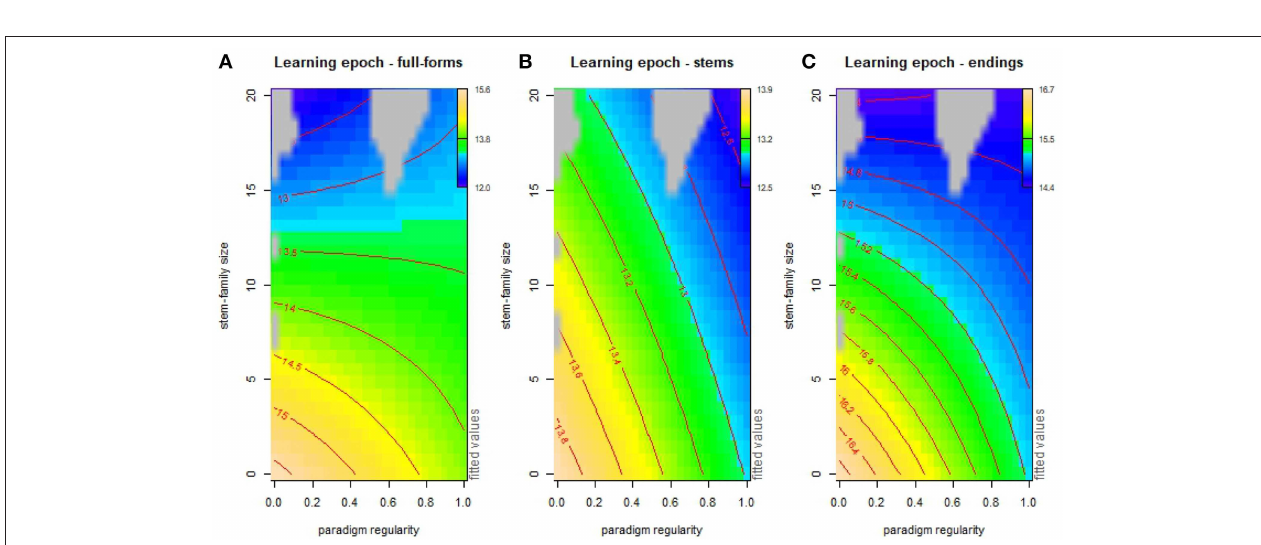
FIGURE 11 | (A) Regression plot of time of lexical acquisition by size of stem-family in linear interaction with word length. Fixed effects are word length (as categorical predictor), and stem-family size; (B) summed effects of paradigm regularity interacting with stem-family size, distance to stem-suffix boundary ( MB ) and word length in a GAM modeling time of acquisition (learning epoch) for verb forms in all sample languages.